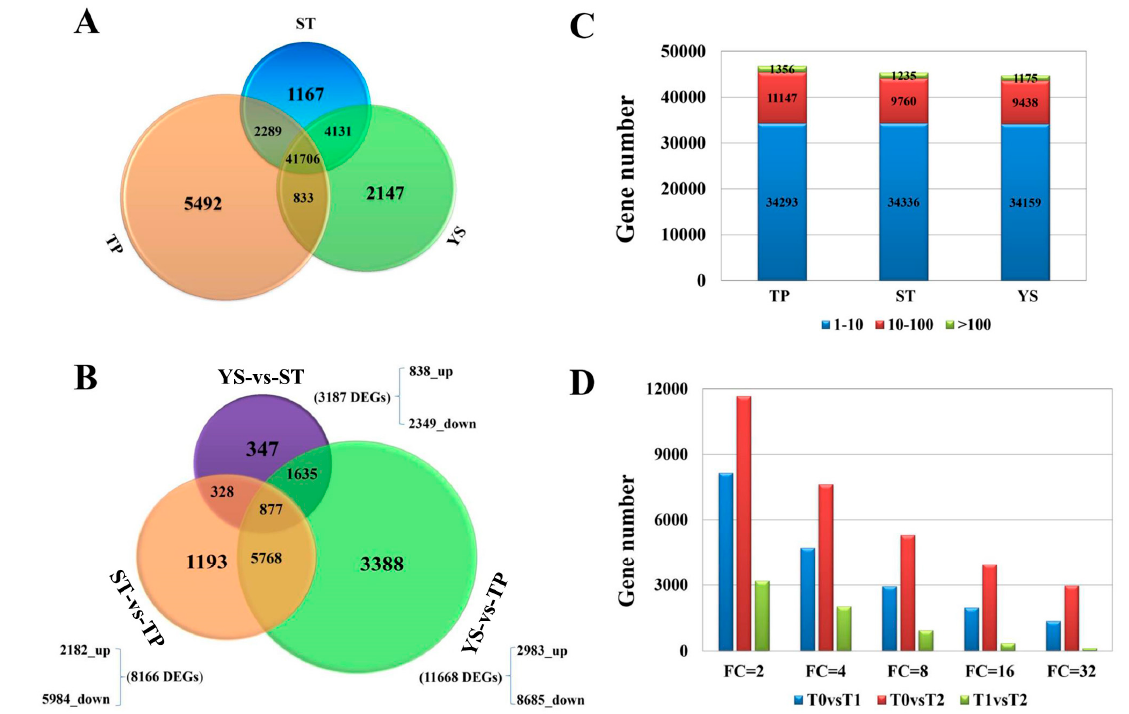
Figure 2. The gene expression profiles in tiller primordia (TP), stem tips (ST), and young spikes (YS) of Guomai 301 . ( A ) A Venn diagram showing the numbers of expressed genes in various samples, the FPKM is above 1 in all three replications. ( B ) Statistics of differentially expressed genes (DEGs) in each sample. ( C ) Numbers of genes expressed in each sample with an average number of fragments per kilobase of transcript per million mapped fragments (FPKM) ≥ 1. ( D ) numbers of DEGs with different Fold Changes.